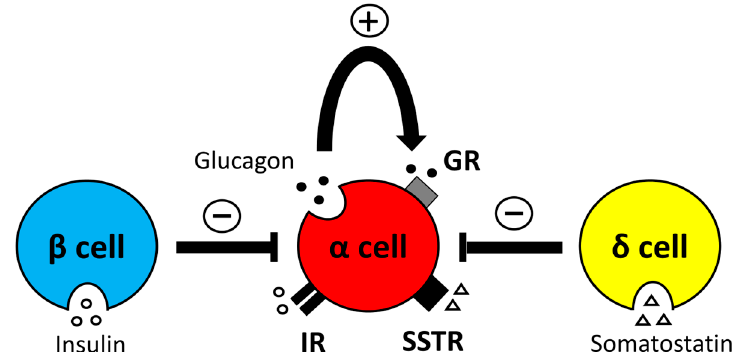
Figure 3. Relationship between islet hormones and glucagon secretion in pancreatic α cells. Insulin, glucagon, and somatostatin subtype 2 receptors are present in α cells. Glucagon secretion in α cells is suppressed by somatostatin and insulin secreted by β and δ cells, respectively. Meanwhile, glucagon secreted by α cells per se enhances glucagon secretion. “ + ”: Enhancement of glucagon secretion. “ − ”: Suppression of glucagon secretion.